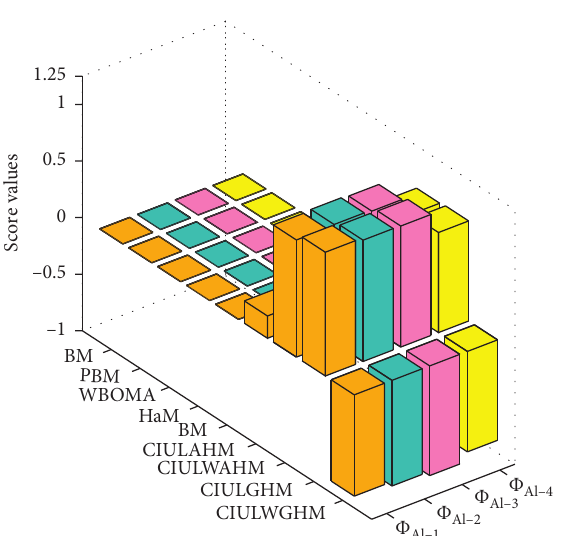
Figure 2: Geometrical interpretation of the information given in Table